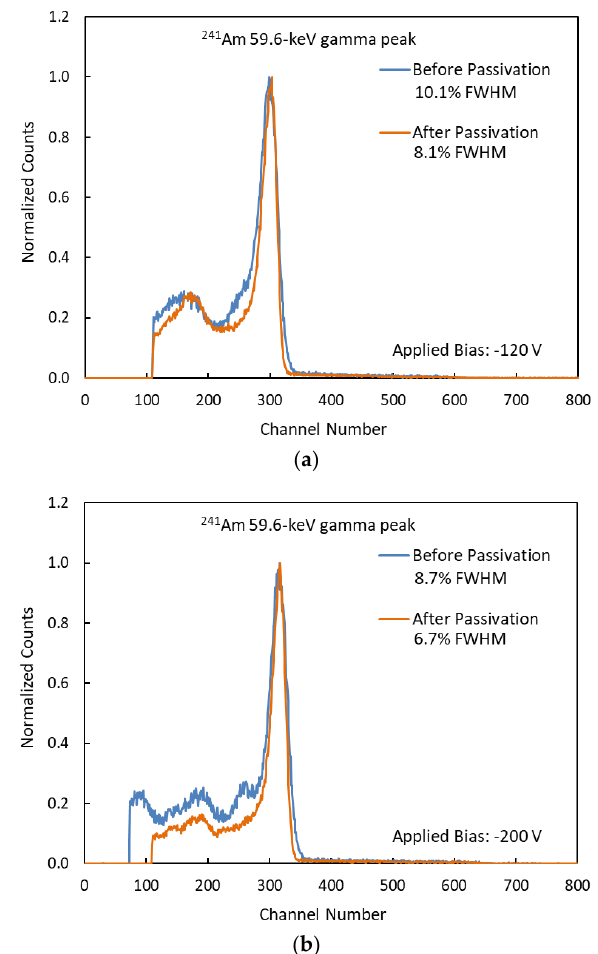
Figure 7. CZTS detector responses to Am-241 source before passivation and 28 days after passivation. The shaping time is 3 µs. ( a ) Detector responses at −120 V. ( b ) Detector responses at −200 V.